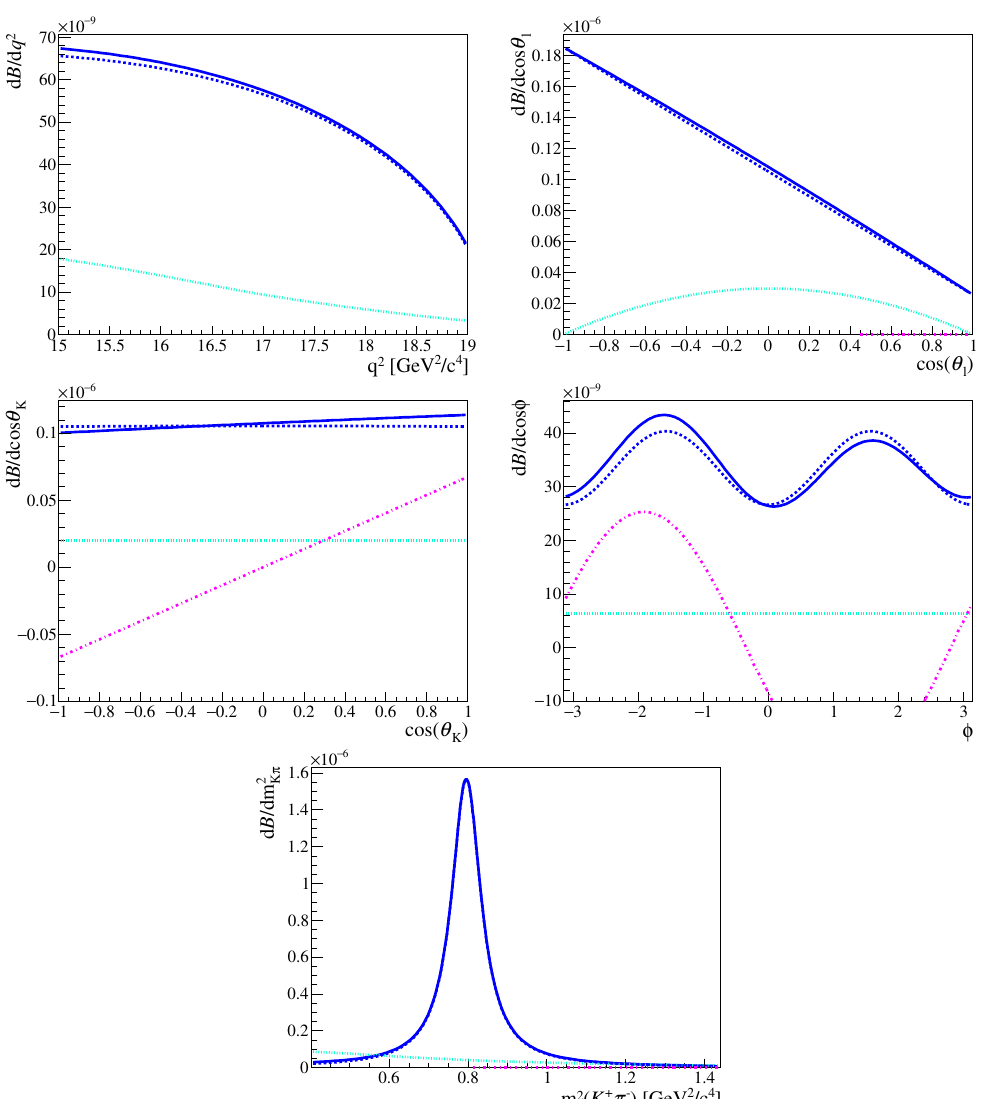
Figure 3. Di(cid:11)erential B 0 ! K (cid:3) 0 (cid:22) + (cid:22) (cid:0) branching fraction depending on q 2 , the three decay angles cos (cid:18) l , cos (cid:18) K and (cid:30) and m 2 in the q 2 range 15 : 0 < q 2 < 19 : 0 GeV 2 =c 4 . The blue solid line denotes K(cid:25) the full P+S-wave prediction, the blue dashed line the P-wave component, the teal dotted line the S-wave component and the magenta dash-dotted line the P-wave/S-wave interference. Both the S-wave component as well as the interference are scaled by a factor 10 to improve readability. The q 2 distribution is only given for illustration, since the prediction relies on integration over a large q 2 range and does not predict any of the present and seen charmonium structures in this q 2 region.